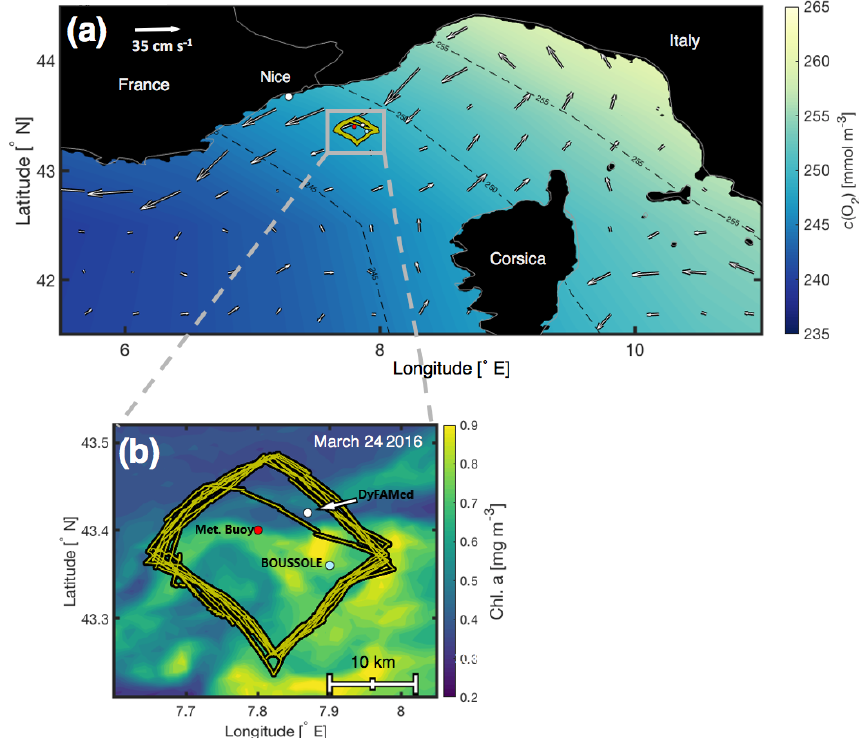
Figure 1. (a) The northwestern Mediterranean Sea and glider deployment area (small grey box) superimposed on the World Ocean Atlas 2013 surface c( O 2 ) March climatology (https://www.nodc.noaa.gov/OC5/woa13/woa13data.htm, last access: 20 August 2022), with accom- panying AVISO satellite absolute mean surface currents (cms − 1 , white arrows) for 6 March–6 April 2016 (http://marine.copernicus.eu/ services-portfolio/access-to-products, last access: 20 August 2022). (b) A close-up of the deployment area at the DyFAMed/BOUSSOLE site. The positions of the glider’s track (yellow), the DyFAMed mooring (43.36 ◦ N, 7.90 ◦ E) (white), the BOUSSOLE buoy (43.42 ◦ N, 7.87 ◦ E), and the meteorological buoy “Côte D’Azur” (43.38 ◦ N, 7.83 ◦ E) are superimposed on surface chlorophyll a concentrations (https://oceancolor.gsfc.nasa.gov/products, last access: 20 August 2022) on 24 March 2016 (Hu et al., 2012). The bathymetry is flat and greater than 2000m